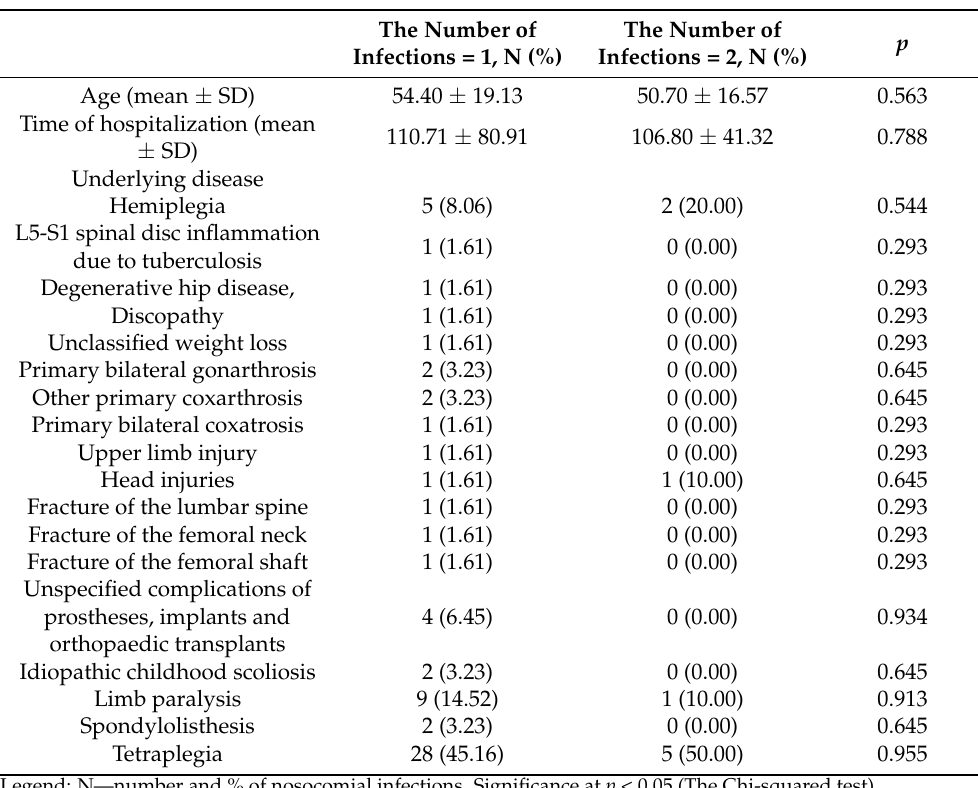
Table 4. Influence of age, time of hospitalization and diseases on the frequency of nosocomial